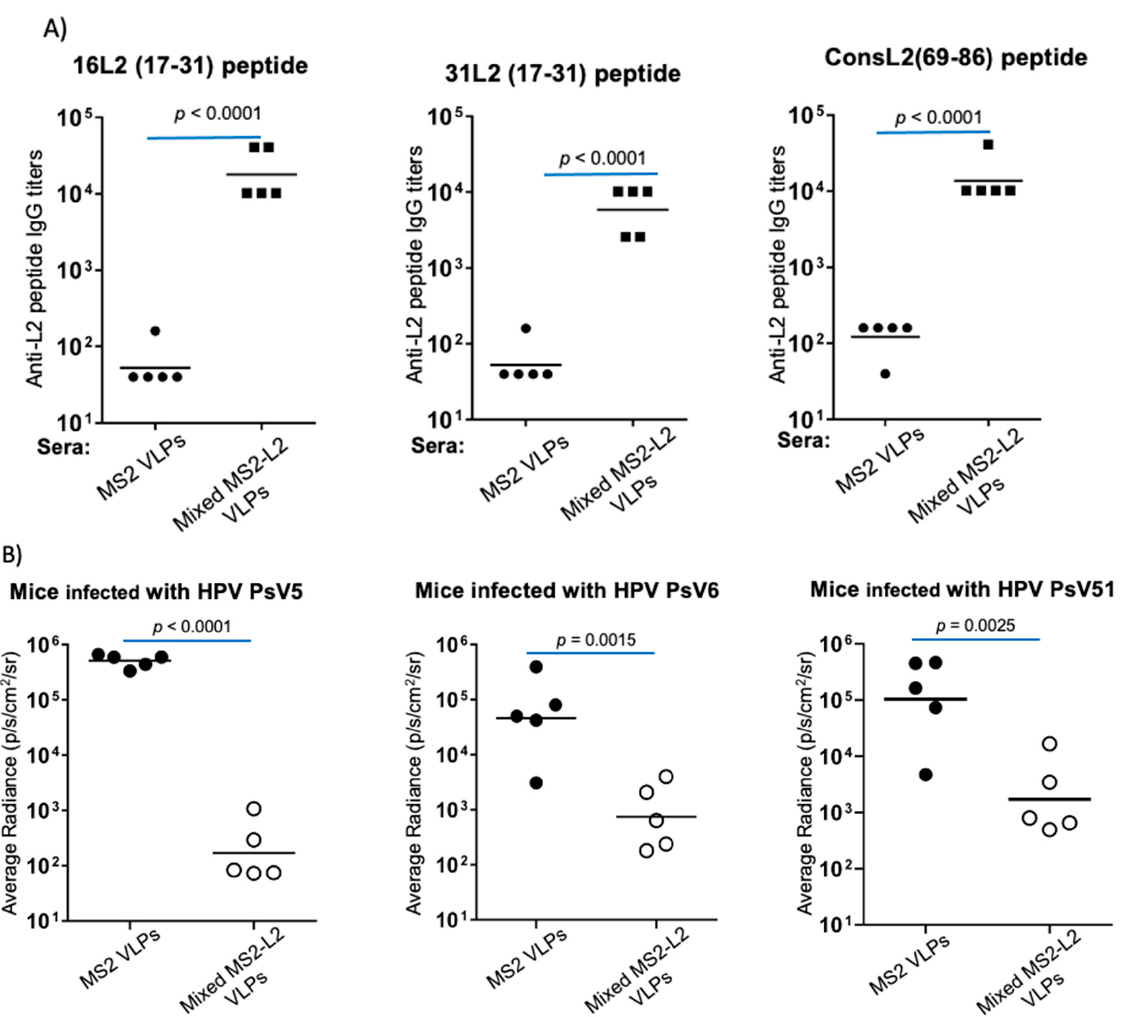
Figure 2. Immunogenicity of mixed MS2-L2 VLPs with alum. Mice were immunized intramuscularly, twice, with 10 µ g of mixed MS2-L2 VLPs or control MS2 VLPs with alum at two-week intervals. ( A ) Sera were collected 2 weeks after the last immunization, and anti-L2 peptide IgG titers in sera were determined by end-point dilution ELISA using the following peptides as target antigens: HPV16 L2 peptide, HPV31 L2, and HPV consL2 (69-86). ( B ) The mice in A above were genitally challenged with 6.4 × 10 6 IU of: HPV PsV5, HPV PsV6, and HPV PsV51. The average radiance ( p /s/cm 2 ) of luciferase expression was determined using Living Image software version 4.5.5. Each datum represents the average radiance of an individual mouse, and the lines represent the geometric mean for each group of mice. The p -values were determined by an unpaired two-tailed t -test for 2A and an unpaired one-tailed t -test for 2B.